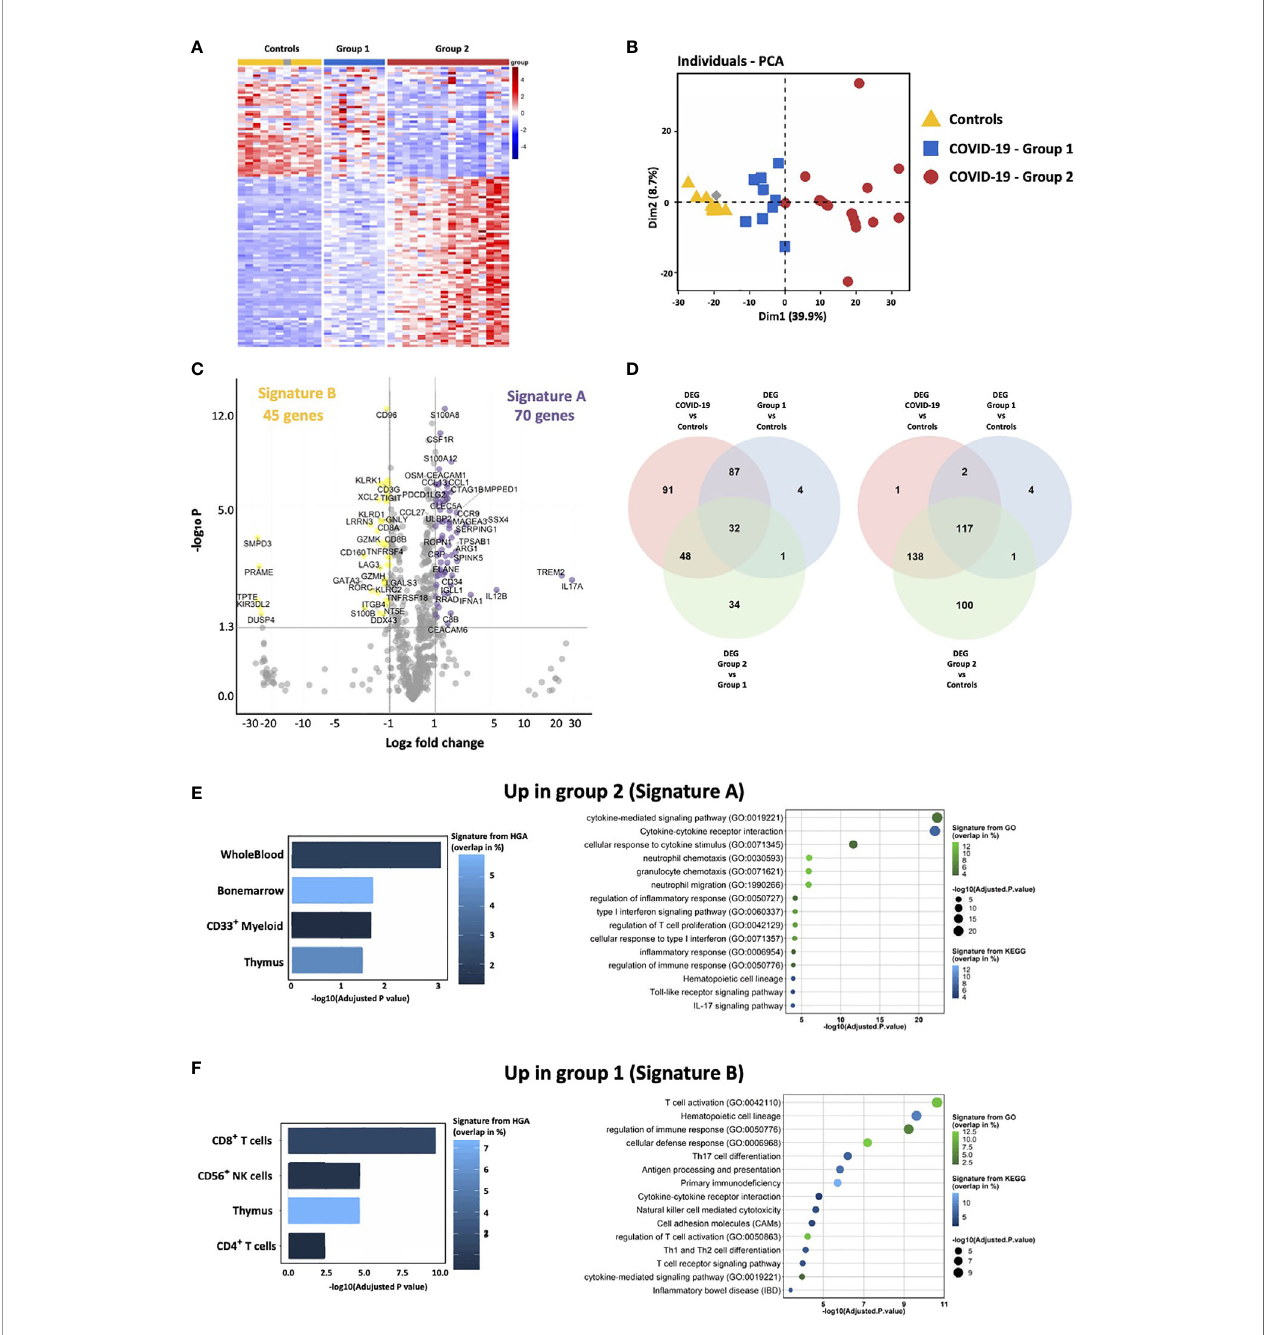
FIGURE 1 | Transcriptomic immune gene signature identi fi es two groups of COVID-19 patients. (A) Heatmap representation showing relative expression of immune genes by COVID-19 and controls reveals the presence of two groups of patients: group 1 (blue) and group 2 (red). (B) Principal component analysis of COVID-19 and controls shows that group 1 is intermediate between controls and group 2 COVID-19 patients. (C) Volcano Plot showing differentially expressed genes between group 2 and group 1. X axis displays fold changes between the two groups and Y axis the − log 10 (p value). Differentially overexpressed genes (Signature A — highlighted in purple) and under-expressed genes (Signature B — highlighted in yellow) by group 2 as compared to group 1 patients were characterized by fold changes superior/inferior to 2 and with a signi fi cant p value (<0.05). (D) Venn diagrams showing common differentially expressed genes between group 1, group 2 and controls. (E, F) Enrichment analysis of genes of the signatures A and B (respectively up-regulated and down-regulated in group 2) using EnrichR and three different datasets. The histogram shows the fi rst fi ve more signi fi cant enriched signatures from The Human Genome Atlas (HGA). corresponding to tissue and cell signatures. The bubble plot shows the fi rst 15 more signi fi cant enriched signatures from the Kyoto Encyclopedia of Genes and Genome (KEGG) and Gene Ontology Biological process (GO), corresponding to biological pathway signatures. Signatures are ordered according to adjusted p-values, the color graduation shows the percentage of genes overlapping between the datasets signature and our own